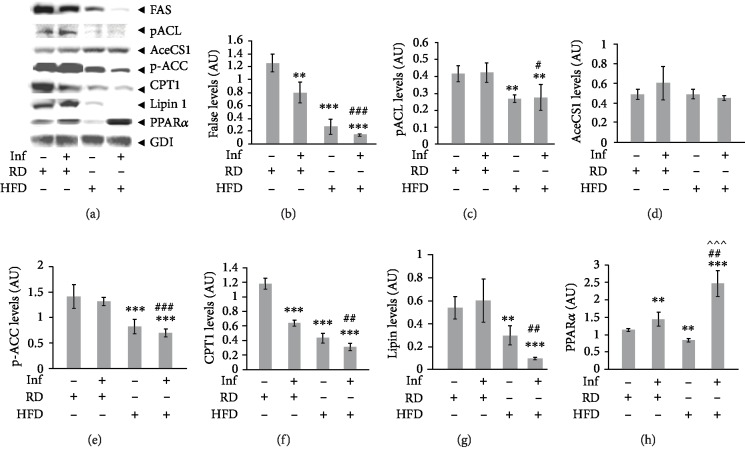
Immunoblot analysis of the livers demonstrated disrupted lipid metabolism in T. cruzi-infected mice and HFD further enhanced interruption of hepatic lipid metabolism during chronic Chagas disease. (a) T. cruzi-infected HFD-fed mice showed significantly reduced hepatic lipid metabolism compared to infected RD-fed mice as demonstrated by immunoblot analysis probed for various lipid metabolism markers such as fatty acid synthase (FAS), phosphorylated ATP-citrate lyase (pACL), phosphorylated acetyl co A carboxylase (p-ACC), carnitine palmitoyltransferase I (CPT1), and Lipin 1. Infected mice showed significantly increased hepatic levels of PPARα, a regulator of fatty acid oxidation compared to uninfected mice, and HFD further enhanced the levels of PPARα in the livers of infected mice. (b–h) Fold changes in the protein levels of FAS, pACL, acetyl CoA-synthase (AceCS1), pACC, CPT1, Lipin 1, and PPARα were normalized to GDI expression and represented as the bar graphs (b–h, respectively). The error bars represent the standard error of the mean. ∗p ≤ 0.05, ∗∗p ≤ 0.01, or ∗∗∗p ≤ 0.001 compared to uninfected RD mice. #p ≤ 0.05, ##p ≤ 0.01, or ###p ≤ 0.001 compared to infected RD mice. ^p ≤ 0.05, ^^p ≤ 0.01, or ^^^p ≤ 0.001 compared to uninfected HFD mice.